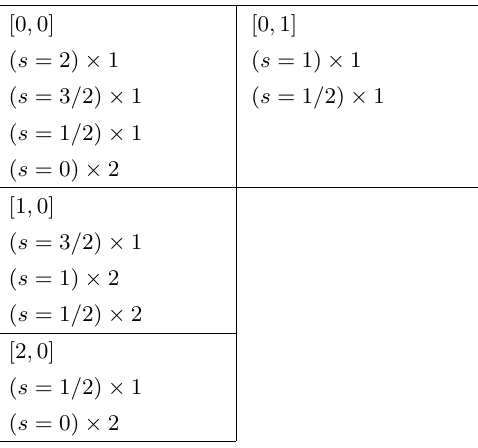
Table 18 . States at KK level n = 0 for the N = 0 G 2 -invariant AdS 4 solution of type IIA.